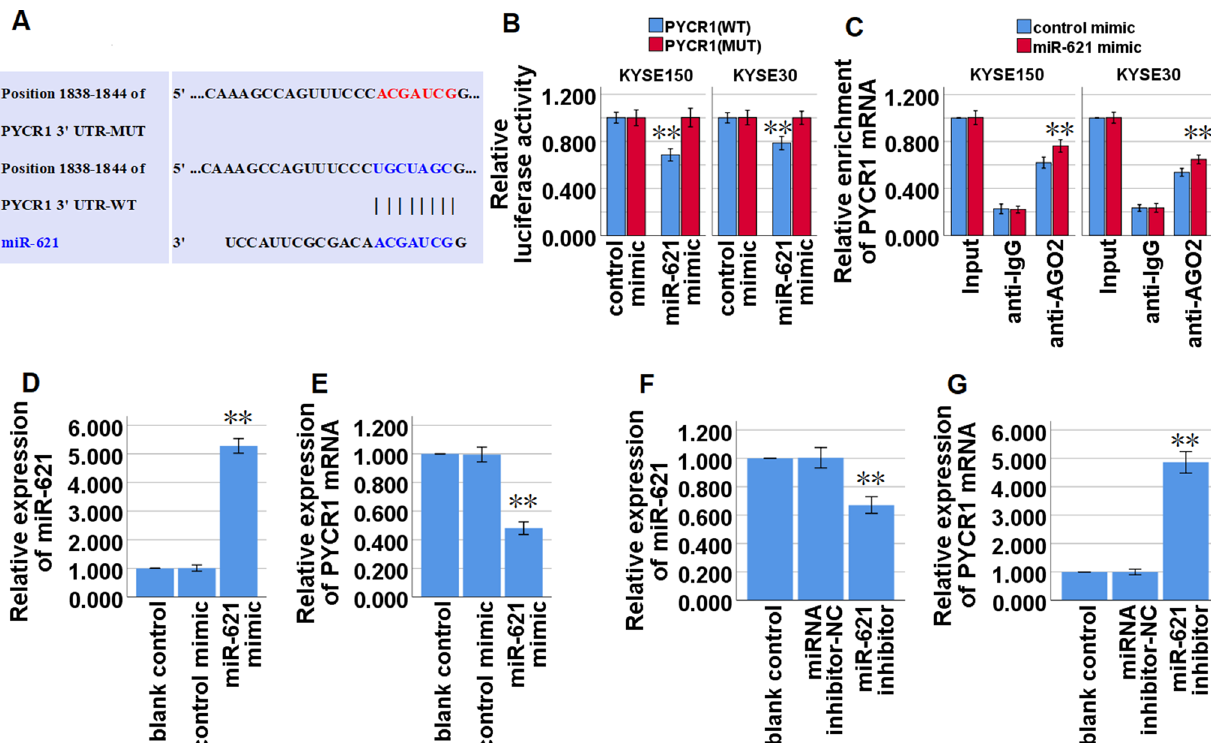
Fig. 5 miR-621 directly binds to PYCR1 mRNA 3 ′ UTR and inhibits PYCR1 expression in ESCC cells. A Bioinformat- ics analysis suggested that PYCR1 mRNA 3 ′ -UTR might share the binding sites with miR-621. The wild-type and the mutated sequences of PYCR1 mRNA 3 ′ -UTR (mutation site: red). B The luciferase activity of KYSE150 and KYSE30 cells in luciferase reporter plasmid containing wild- type PYCR1 mRNA 3 ′ -UTR (PYCR1-WT) and mutant PYCR1 mRNA 3 ′ -UTR (PYCR1-MUT) co-transfected with miR-621 mimic or negative con- trol was assessed. C RIP assays using antibodies against AGO2 or IgG control were performed in cellular lysates from KYSE150 and KYSE30 cells. qRT-PCR demonstrated the relative enrichment of PYCR1 mRNA in the cells transfected with miR-621 micmic or control mimics. D qRT- PCR analysis of miR-621 expression in KYSE150 cells transfected with miR-621 mimic or control mimics. E qRT-PCR analysis of PYCR1 mRNA expression in KYSE150 cells transfected with miR-621 mimic or control mimics. F qRT-PCR analysis of miR-621 expression in KYSE30 cells transfected with miR-621 inhibitor or miRNA inhibitor-NC. G qRT-PCR analysis of PYCR1 mRNA expression in KYSE30 cells transfected with miR-621 inhibitor or miRNA inhibitor-NC. * P < 0.05, and ** P < 0.01 vs